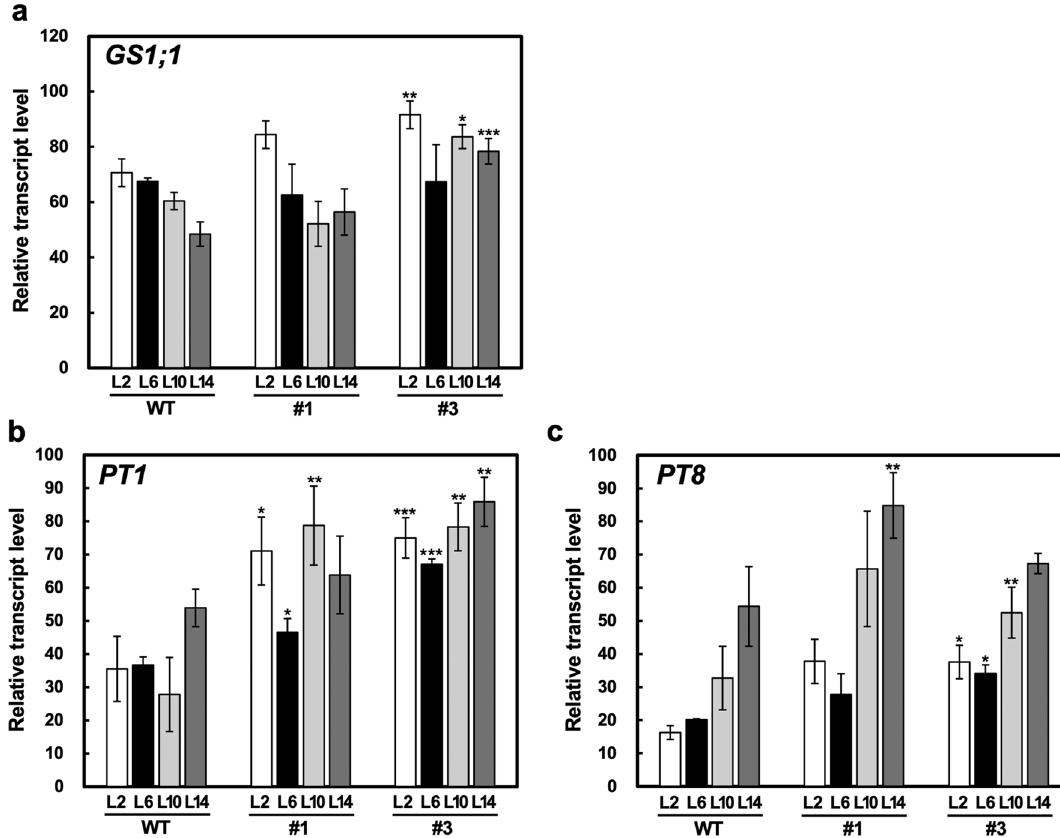
Figure 4. Transcript levels of GS1;1 ( a ), PT1 ( b ), and PT8 ( c ) in the shoots of the wild-type (WT) and R1 - Cas #1 and #3 plants at the 4-leaf stage. The plants were grown in a low concentration hydroponic nutrient solution under normal conditions and harvested 2 h (L2), 6 h (L6), 10 h (L10), and 14 h (L14) after the onset of illumination. The transcript levels are normalized to those of RUBQ2 , and the highest transcript level is defined as 100. Data are presented as the average ± standard error of the mean ( n = 3). Asterisks indicate significant differences relative to the WT plants based on the Student’s t -test (* p < 0.05, ** p < 0.01, and *** p <